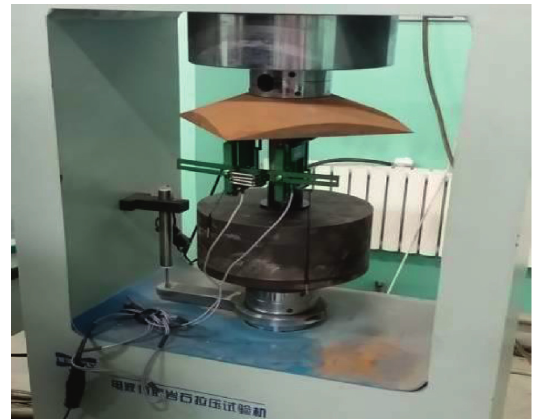
Figure 3: Uniaxial compression test.